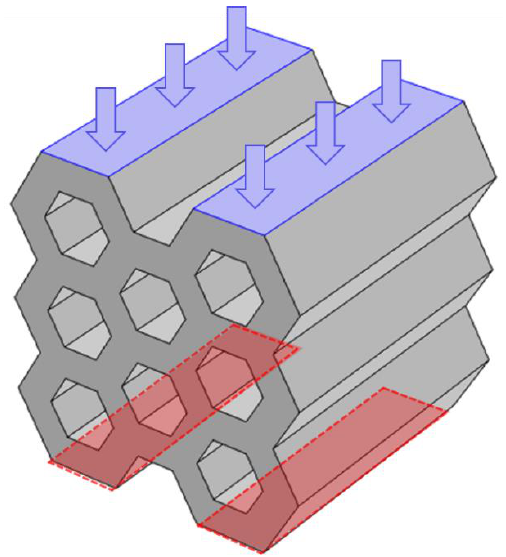
Figure 3. Representation of the simulation set-up. The upper boundary on which the vertical displacement was applied is represented in blue and the fixed bottom boundary in red.